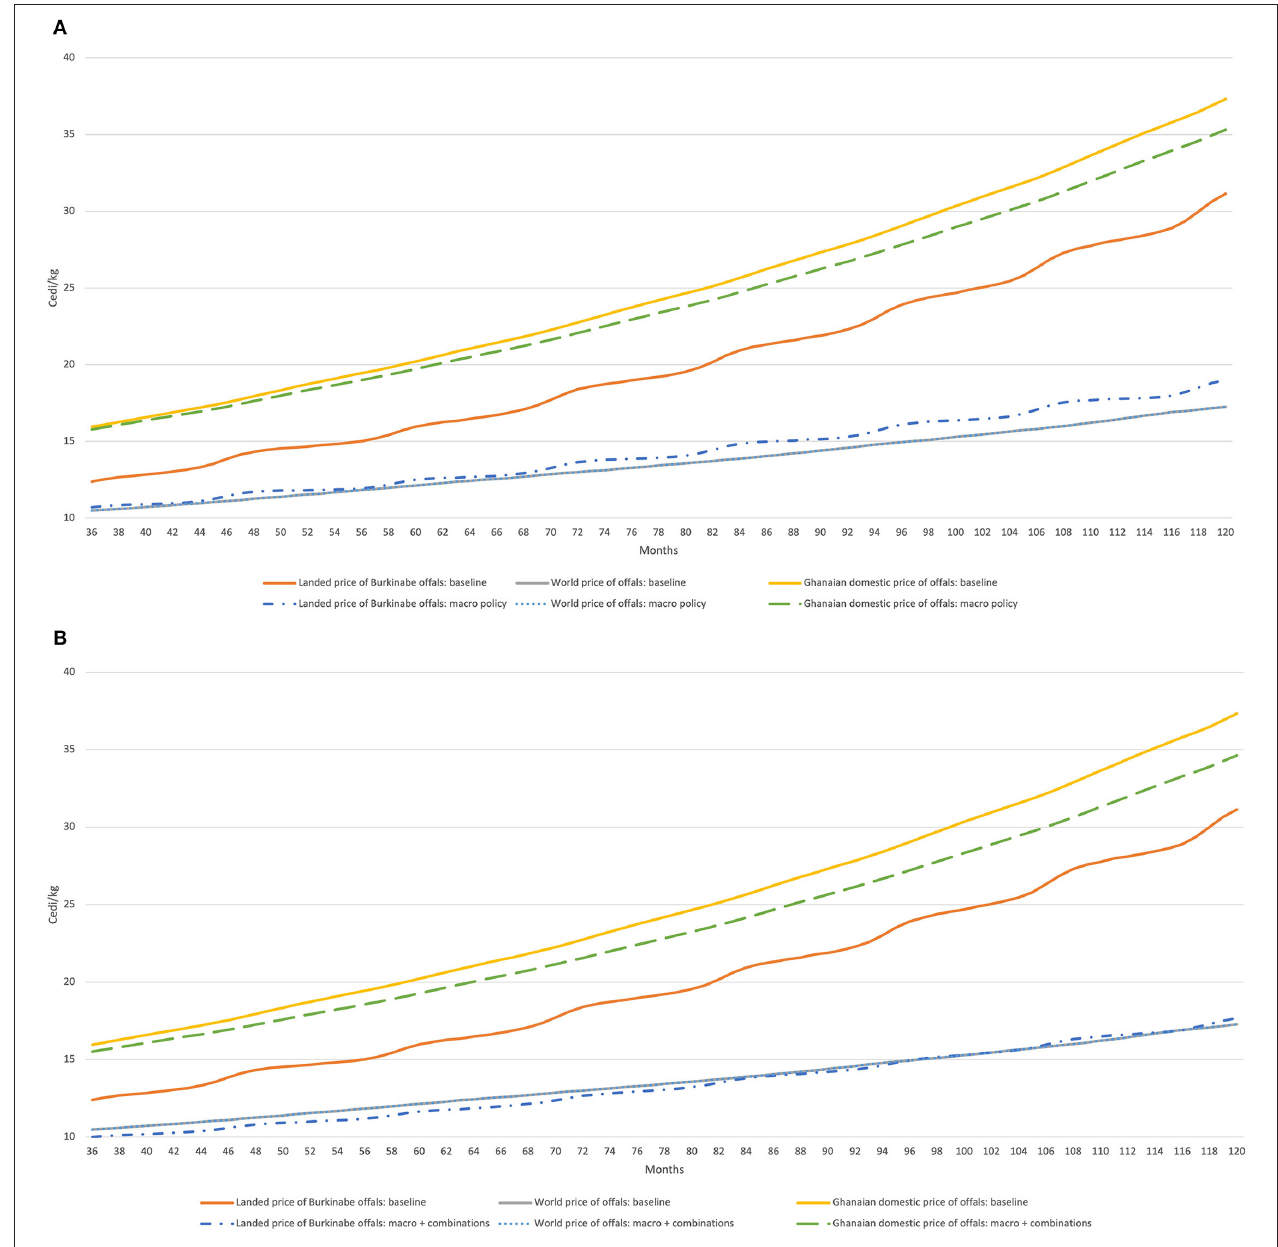
FIGURE 6 | Evolution of offal prices in Burkina Faso, Ghana, and world markets (Cedi/kg) under alternative macroeconomic regimes. (A) Baseline plus no depreciation of the Cedi vs. the CFA. (B) Macroeconomic changes from (A) + combinations of strategies (from Figure 5E ). Model